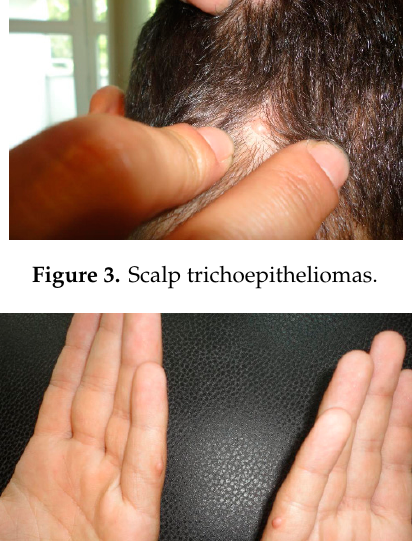
Figure 6. Scalp cylindroma. Case 4: A 62-year-old female patient presented with erythematous nodules on the scalp and trunk as well as skin-colored papules on the face. The patient stated that her father and sister showed similar, unique scalp nodules. The clinical examination revealed the presence of numerous firm, erythematous, asymptomatic nodules, some of them confluent, with smooth surface, accompanied by telangiectasias (Figures 7 and 8) Simultaneously, multiple skin-colored papules, 1–8 mm in diameter, were identified on the face (Figure 9) The patient’s general health was normal and routine laboratory investigations were within normal limits. Biopsies from two nodules of the scalp were taken. They showed typical features of cylindroma (Figure 10) and spiradenoma, respectively. Regarding the facial papules, the histology revealed trichoepitheliomas. Furthermore, a tumoral lesion of the anterior thorax was excised. The histopathological exam confirmed the diagnosis of superficial basal cell carcinoma. Figure 7. Scalp cylindromas and spiradenomas.